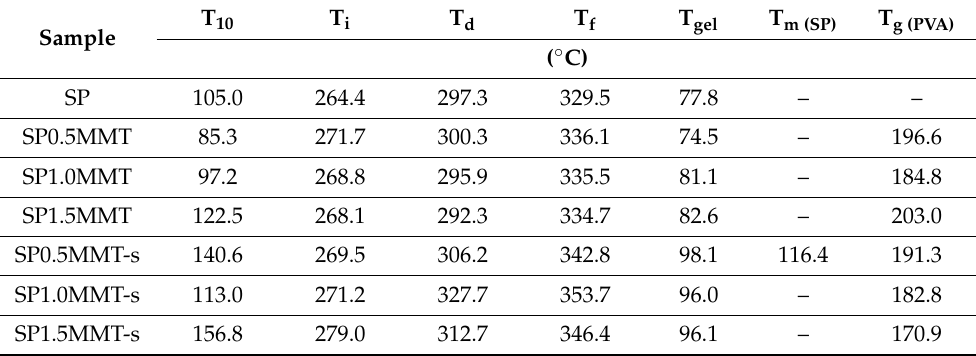
Table 2. Weight losses of 10% (T 10 ), initial degradation (T i ), maximum degradation (T d ), final deg- radation (T f ), glass transition (T g ) and melting (T m ) temperatures, results based on the obtained TGA and DSC thermograms for the bionanocomposites.